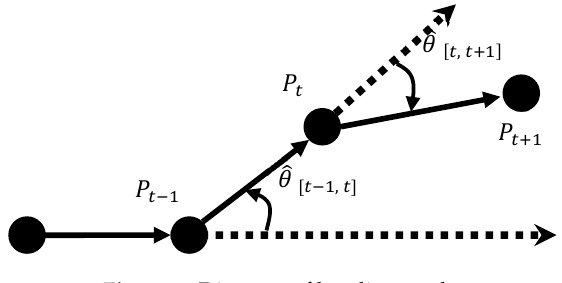
Figure 2. Diagram of heading angle .